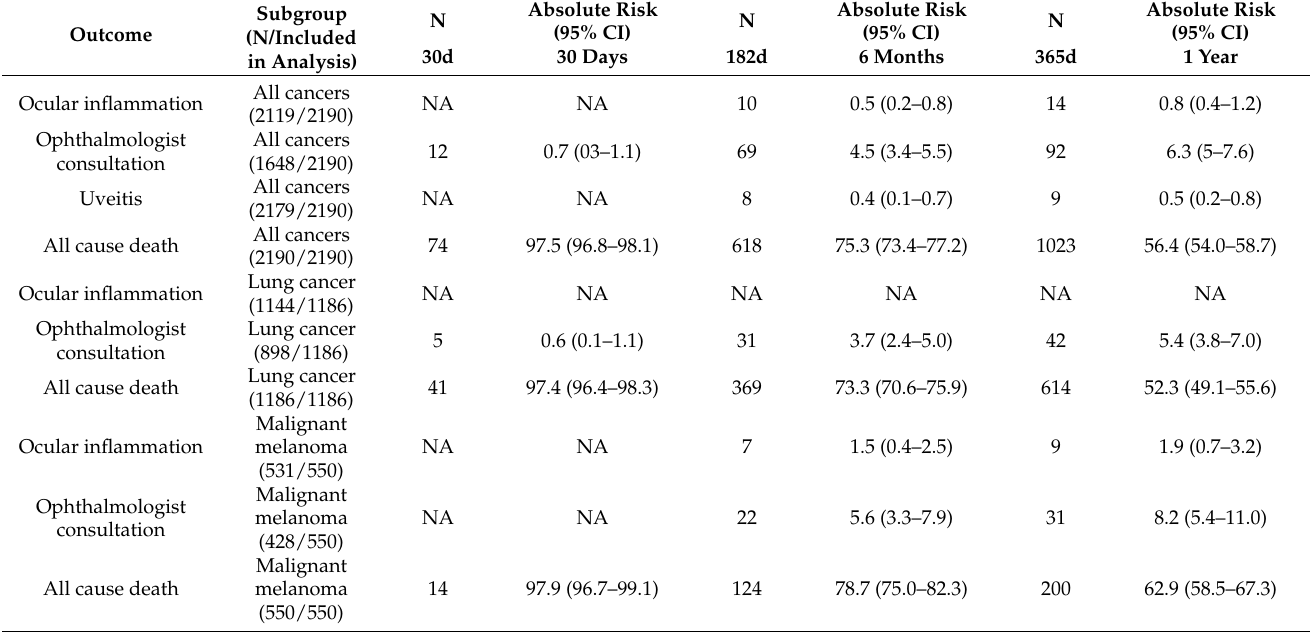
Table 3. Absolute risks at 30 days, 6 months, and 1 year after initial